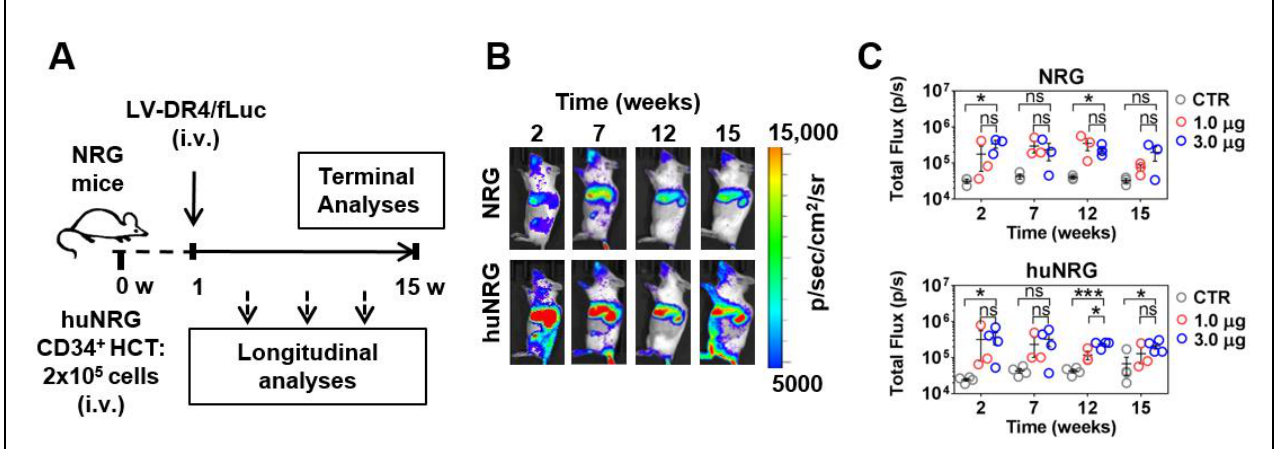
Figure 5. Administration of LV-DR4/fLuc vector intravenously (i.v.) into NRG and huNRG mice and bioluminescence imaging (BLI) analyses. ( A ) Experimental design for testing of LV-DR4/fLuc vector in NRG (CTR: n = 3, 1 μ g: n = 3, 3 μ g: n = 3), and huNRG mice (CTR: n = 4, 1 μ g: n = 3, 3 μ g: n = 4); ( B ) Representative BLI pictures of NRG and huNRG mice injected i.v. with 3 μ g p24 equivalents of LV-DR4/fLuc vector; ( C ) Quantitative BLI signal obtained by quantifying region of interest (ROI) in spleen from each mouse in NRG and huNRG mice injected i.v. with PBS (CTR), 1 μ g, and 3 μ g p24 equivalents of LV-DR4/fLuc vector. Dose-finding experiments . * p < 0.05, *** p < 0.001, ns: not statistically significant ( t - test, unpaired).